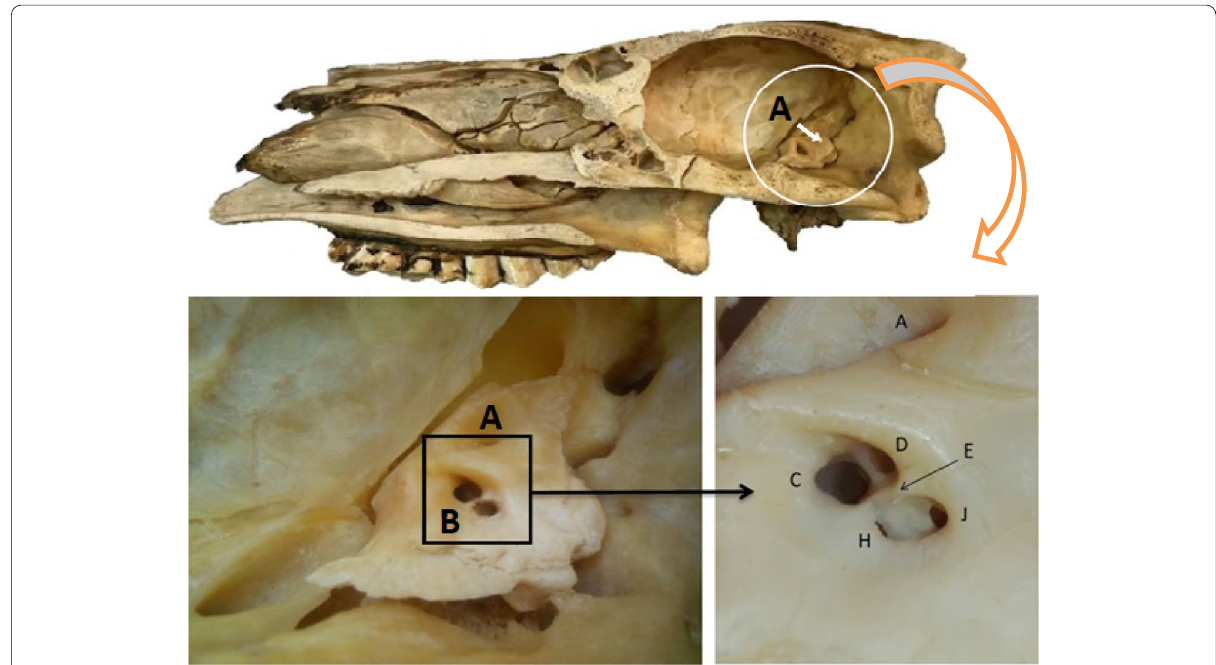
Fig. 5 The sagittal section in the camel skull. A. Petrosal bone and gross morphological image of the camel internal acoustic meatus. A. Subarcuate fossa, B. Internal acoustic meatus, C. Facial nerve foramen, D. Foramen for utricle and the ampullae of the anterior SC nerve, H. Foramen for cochlear nerve, J. Foramen for saccule and the ampulla of the posterior semicircular canal, E. Ridge dividing the upper and lower part of the internal acoustic meatus